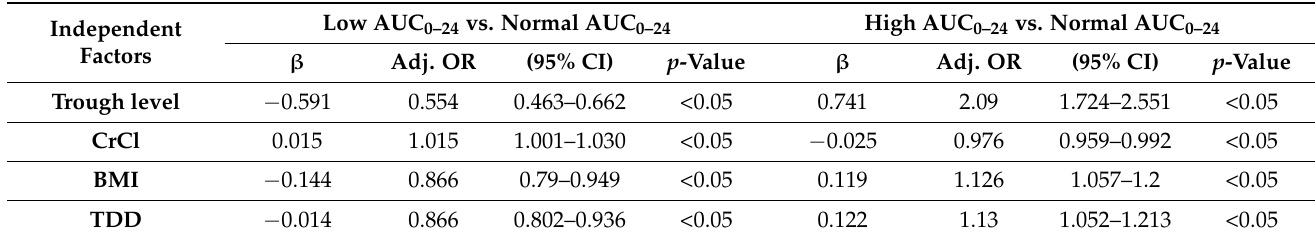
Table 2. Multinomial logistic regression analysis of the factors for the patient being in the low or high AUC 0–24 group as compared with normal AUC 0–24